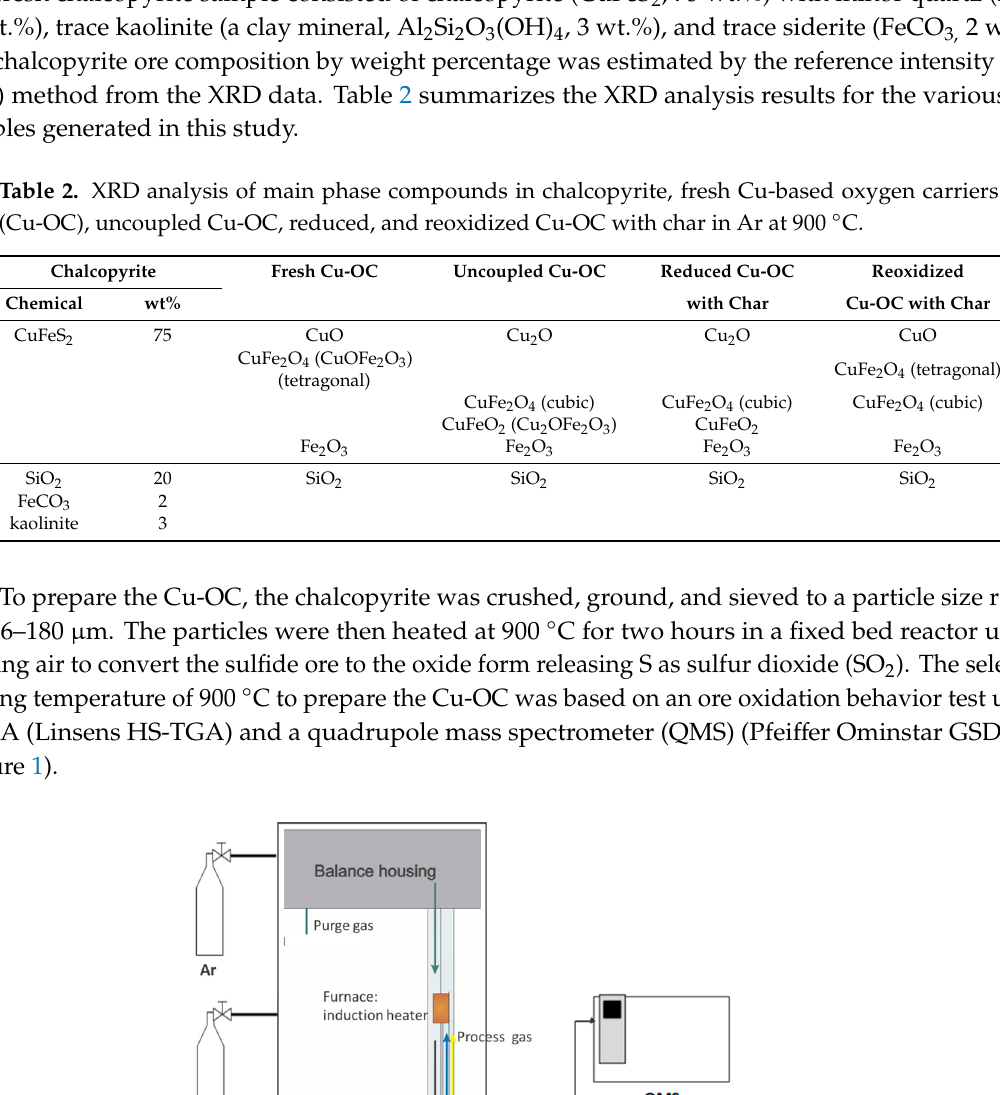
Table 2. XRD analysis of main phase compounds in chalcopyrite, fresh Cu-based oxygen carriers (Cu-